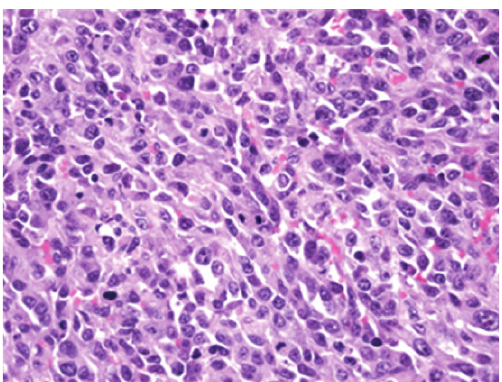
Figure 1: Sheet-like growth pattern, high-grade cytological atypia, and numerous mitotic figures are depicted in this radiation- associated angiosarcoma of the oral cavity. 7/9 cases (77.8%) of radiation-associated tumors in this study were high grade (H&E, 400x).